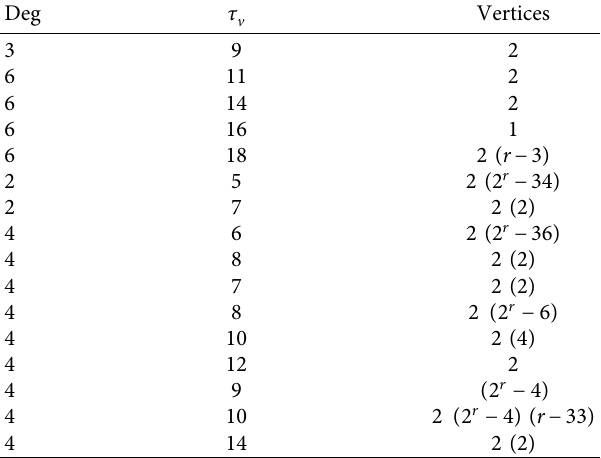
Table 1: Vertex partition of HCB ( r ) corresponding to connection numbers and degrees.